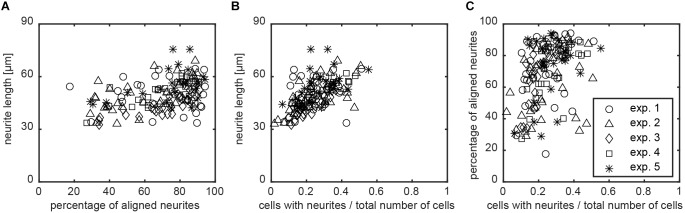
Relation between neurite alignment, neuronal differentiation, and nanogrooves. To study whether neurite alignment and differentiation of the SH-SY5Y cells on nanogrooved patterns correlate and whether the pattern structure had an influence on these properties, scatterplots were used to visualize the relation between these parameters. (A–C) Data for which Spearman’s non-parametric correlation coefficients were calculated using a two-tailed P-value and 99% confidence interval. For all cases shown, P < 0.01 holds true, where graphs are neurite length versus alignment with correlation coefficient r = 0.746 (A), neurite length versus differentiated cells in total population with r = 0.814 (B), and alignment versus differentiated cells in total population with r = 0.731 (C). The legend shows markers for data of each experiment for plots (A–C).